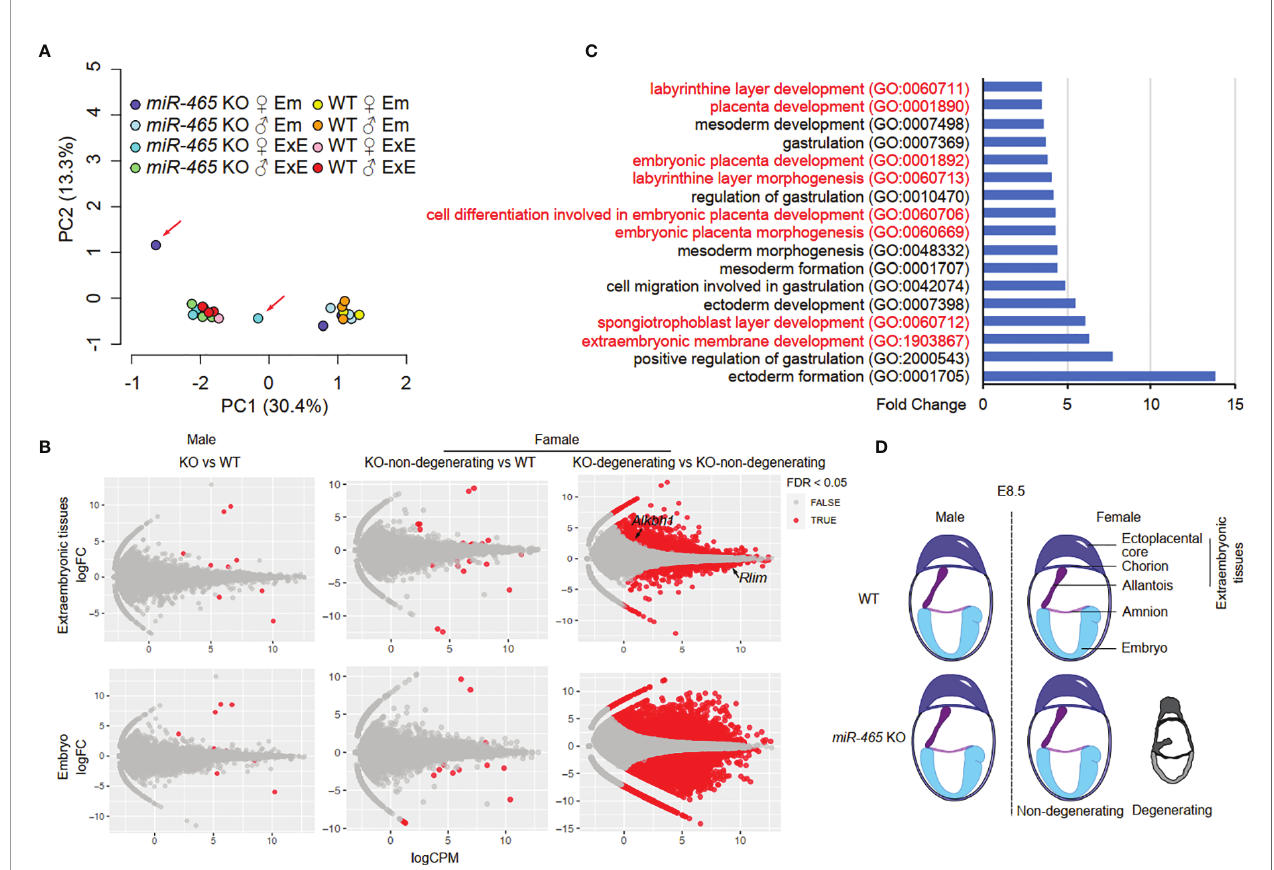
FIGURE 4 | RNA-seq analyses of miR-465 KO and WT conceptuses. (A) Principal component (PC) analyses of RNA-seq data from embryonic (Em) and extraembryonic (ExE) tissues of miR-465 KO and WT mice. The red arrows indicate the degenerating embryo and extraembryonic tissues from a miR-465 KO female conceptus. (B) Differentially expressed genes (DEGs) identi fi ed in the following three comparisons: between the miR-465 KO and WT males (left), between the miR-465 KO non-degenerating and WT females (middle), and between miR-465 KO degenerating and non-degenerating females (right). (C) GO term enrichment analyses of DEGs between the degenerating and